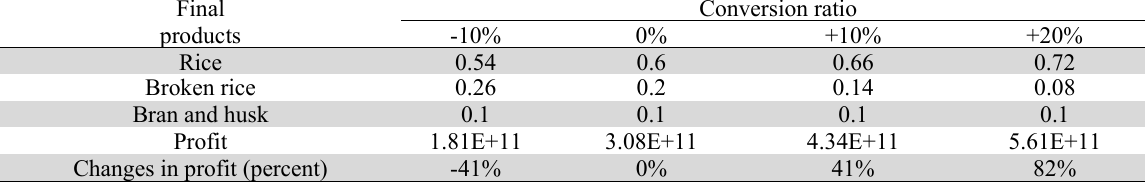
Total profit vs. conversion ratio of paddy to final products